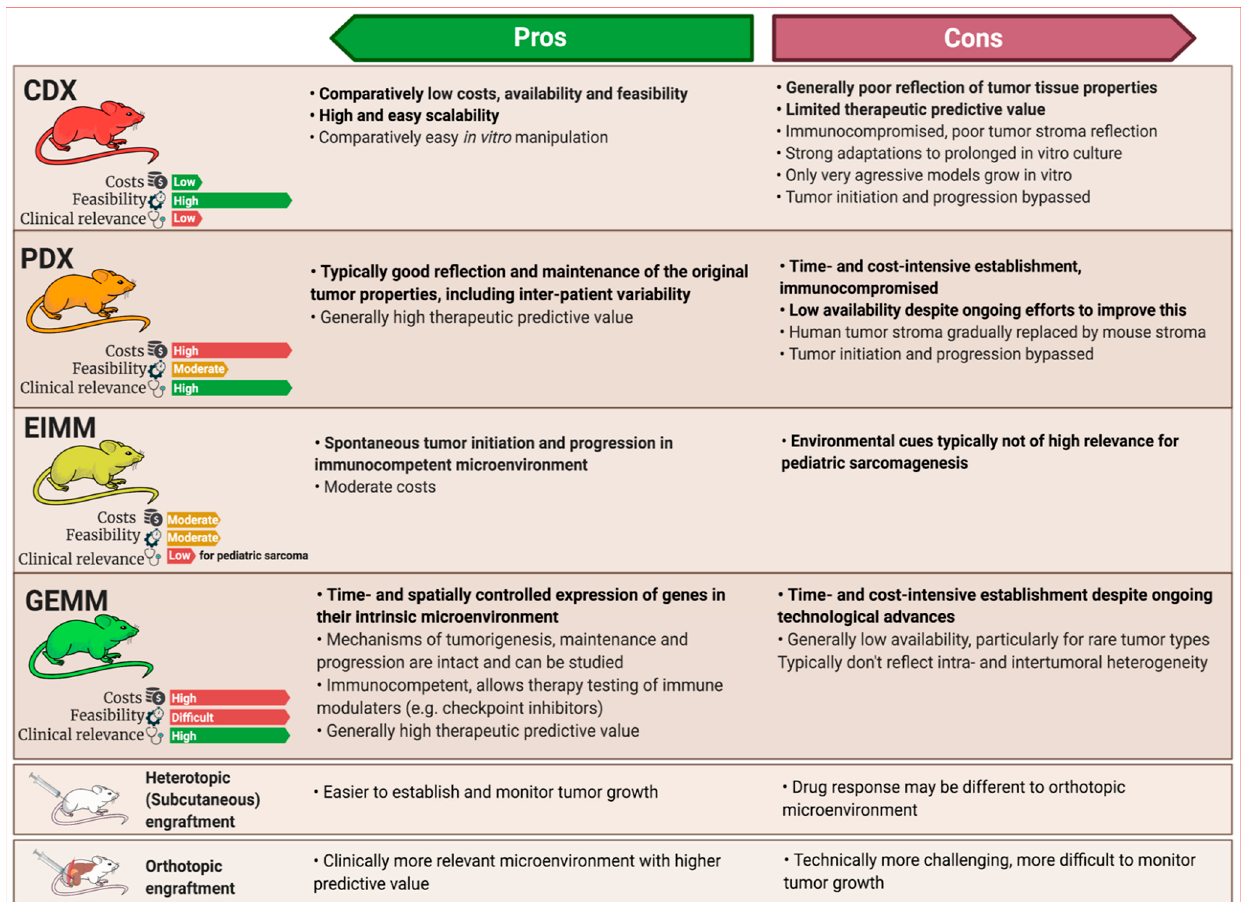
Figure 3. Pros and cons of different in vivo modeling approaches. While cell-line-derived xenograft models (CDXs) and patient-derived xenograft models (PDXs) are both engraftment models, environmentally-induced models (EIMMs) and genetically-engineered mouse models (GEMMs) can be utilized to establish syngeneic engraftment models (SAMs), enabling scalability for these models, too. Pros and cons of different engraftment sites depicted at the bottom apply to all of the engraftment models, regardless of origin.